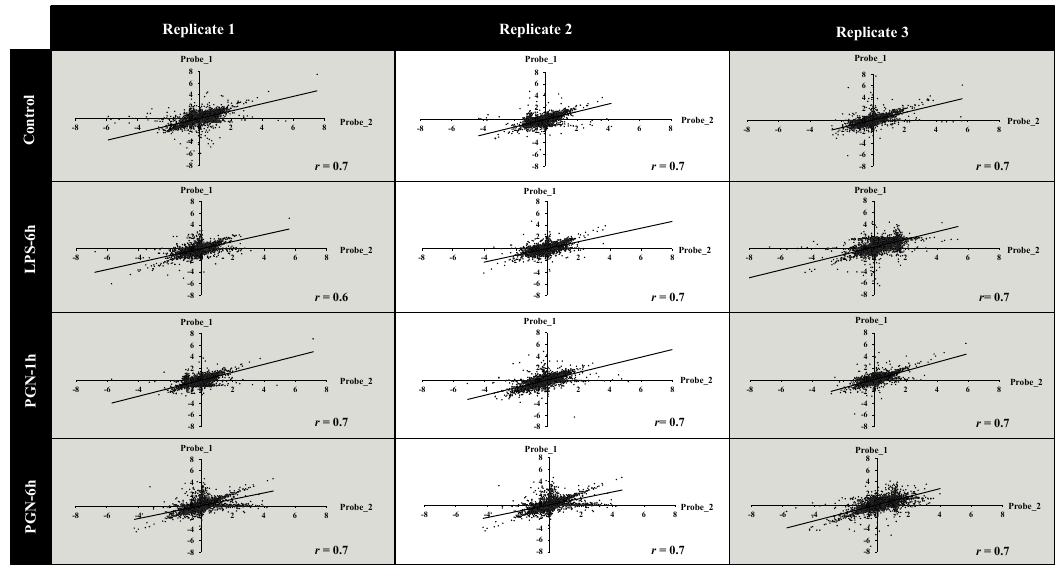
Figure 1. Scatter plot analysis of hybridization success across 12 microarray experiments. To evaluate probe correction in the expression data for annotated target (three probes/target) we randomly selected two of the three probes present for each target (technical bias). For each gene, Pearson correlation coefficient was calculated within arrays. LPS, lipopolysaccharide; PGN, peptidoglycan.